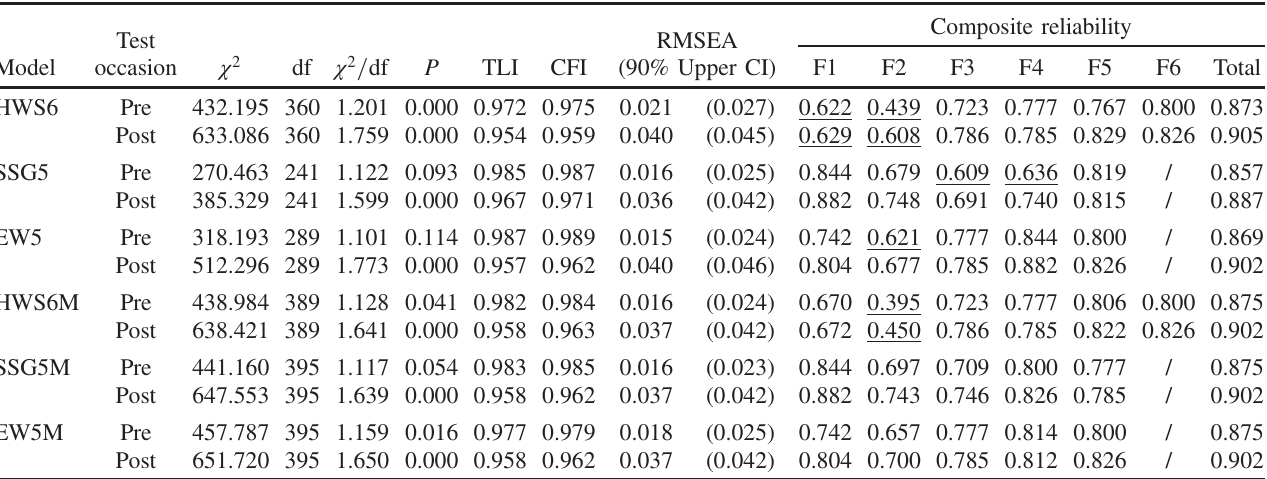
TABLE IV. Fit statistics for the six models of FCI applied to the pre- and post-test datasets separately. The reliability estimates for the subscales and the whole FCI were computed using CR. Values of CR below the minimally acceptable level (0.65) were